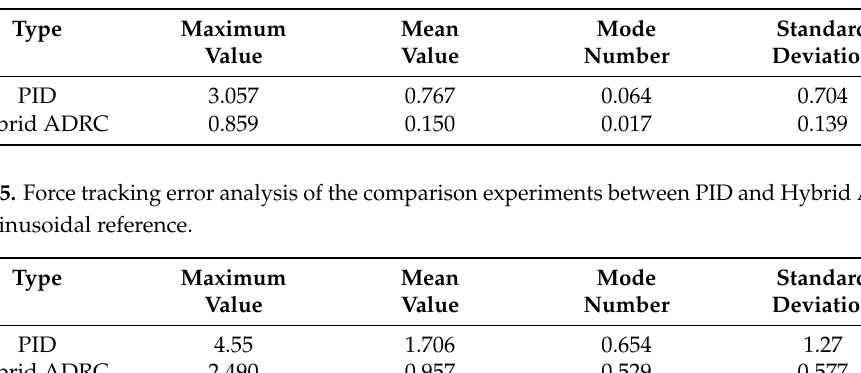
Figure 13. Comparison experiments between Hybrid ADRC and PID. ( a ) Experiments with step Reference. ( b ) Experiments with sinusoidal Reference. Table 4. Force tracking error analysis of the comparison experiments between PID and Hybrid ADRC with step reference.